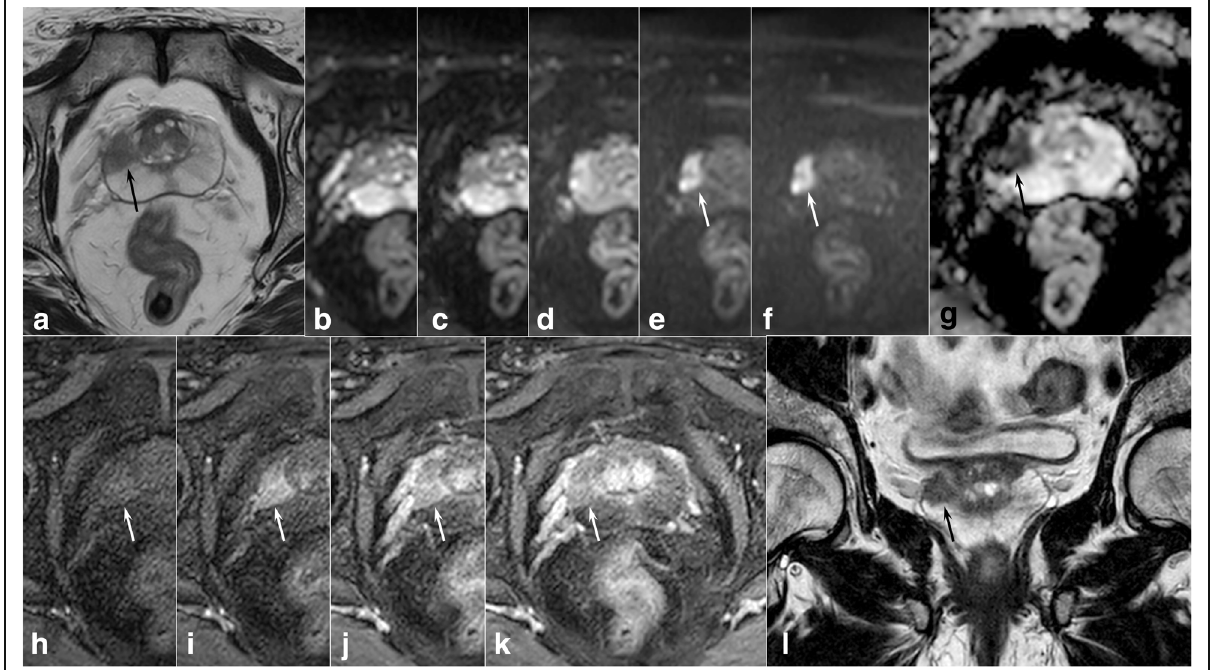
Fig. 1 Prostate multiparametric magnetic resonance imaging showing a neoplastic lesion of the right peripheral zone (arrows). The lesion is hypointense on axial ( a ) and coronal ( l ) T2-weighted images and demonstrates diffusion restriction on diffusion-weighted images ( b values 0, 100, 500, 1000, and 1400 s/mm 2 , from b to f , respectively), confirmed by the apparent diffusion coefficient map ( g ). Lesion enhancement is also evident on dynamic contrast-enhanced perfusion-weighted imaging (from h to k ). PI-RADSv2 diagnostic category: